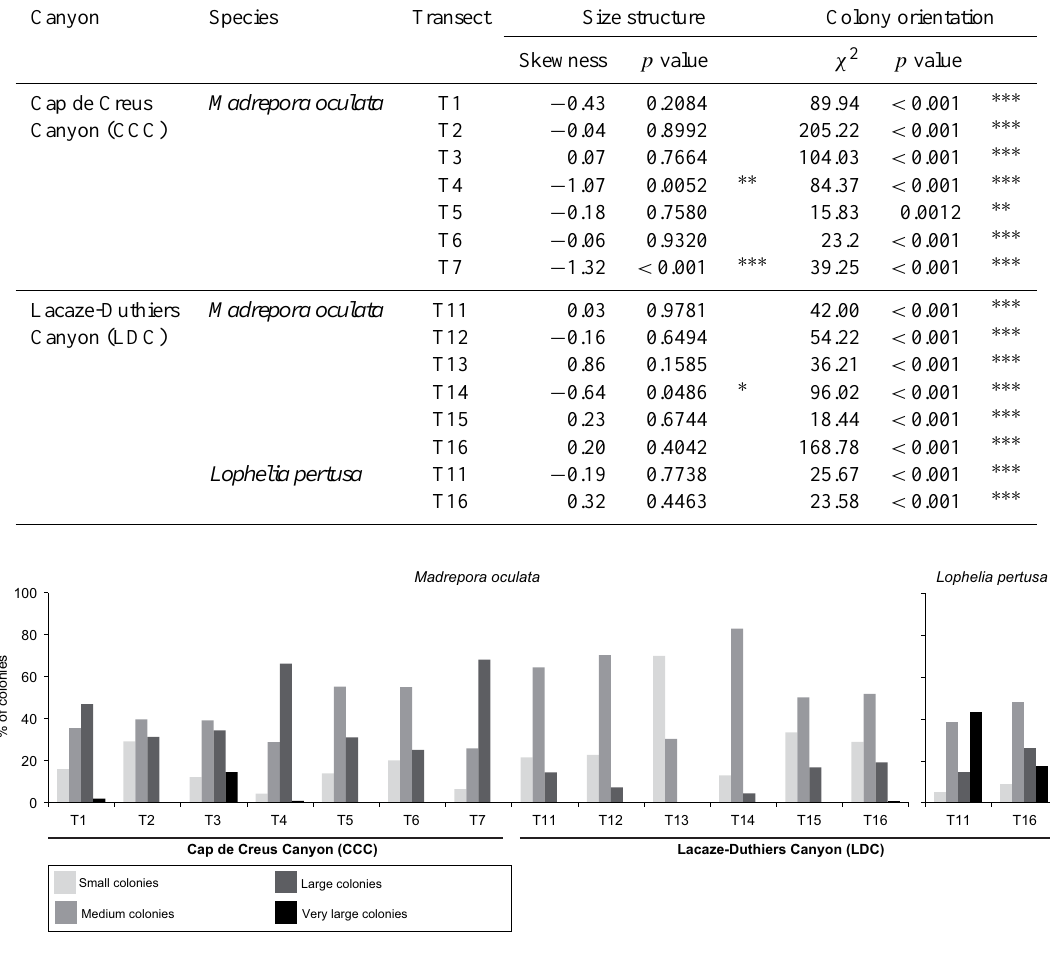
Fig. 4. Size–frequency distribution of Madrepora oculata and Lophelia pertusa populations in the Cap de Creus Canyon (CCC) and the Lacaze-Duthiers Canyon